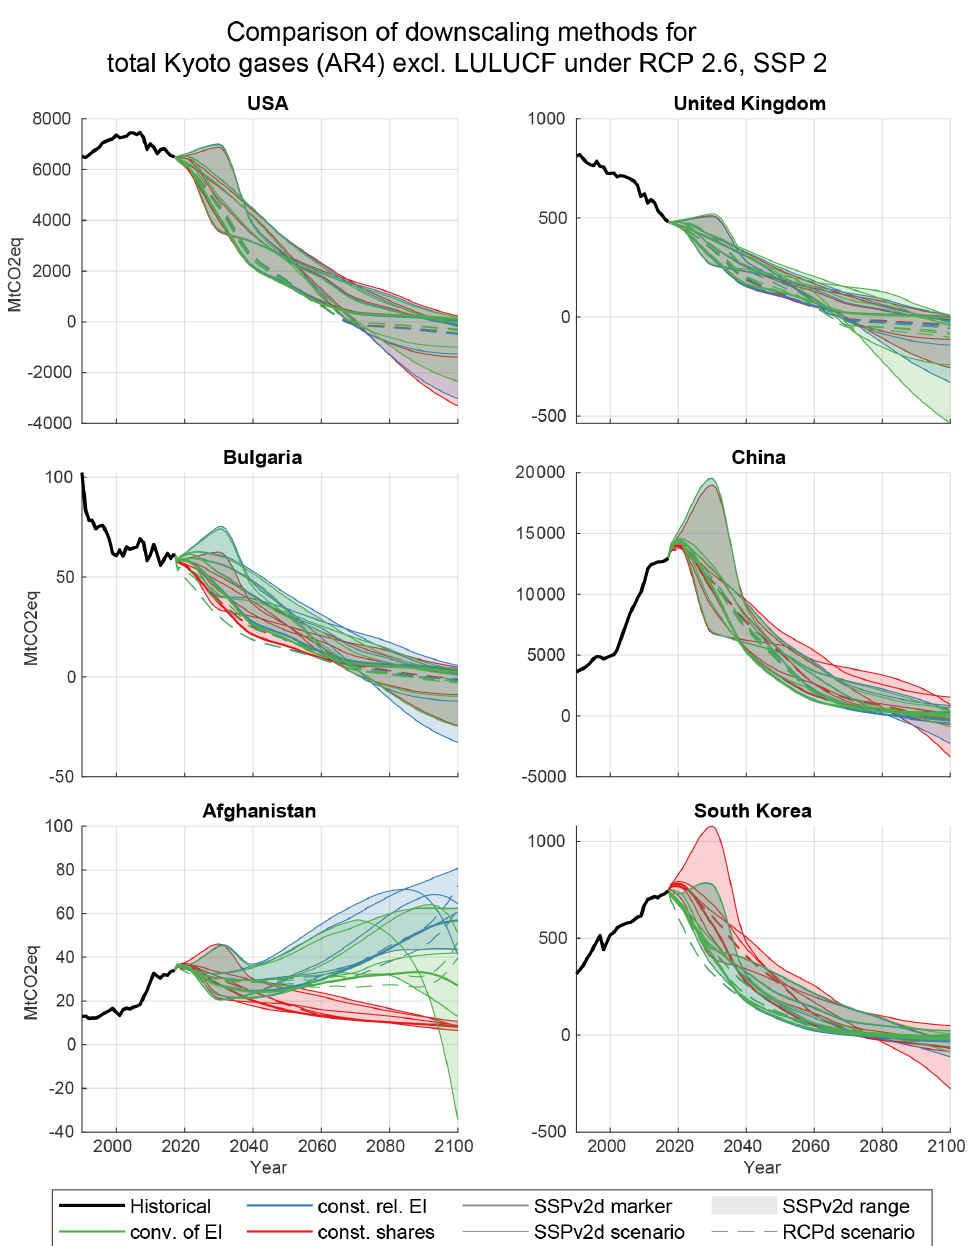
Figure 10. Influence of the downscaling method on country emissions for RCP2.6 and SSP2. Ranges are calculated over all IAM imple- mentations in SSPv2d. RCPd scenarios are shown as individual lines only (dashed). For the OECD region the influence of the downscaling method is comparable to the influence of the IAM modeling group but with a clear influence of high GDP growth on emissions in the second half of the century. Countries in the Asia region have a more diverse GDP development (Fig. 6) and show a much stronger influence of the downscaling